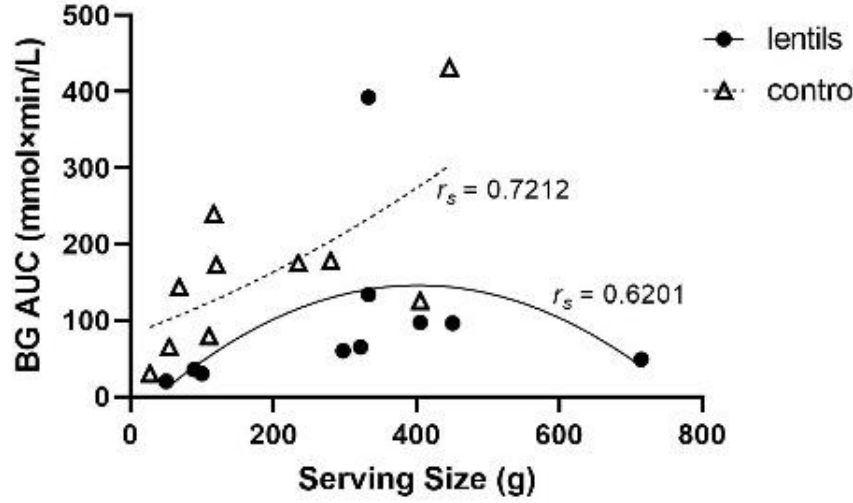
Figure 1. Area under the blood glucose response curve (BG AUC) for various lentil and control serving sizes (g). A quadratic model best fit the lentil ( r s = 0.6201; n = 10; ns ) and control data ( r s = 0.7212; n = 10; p < 0.05).